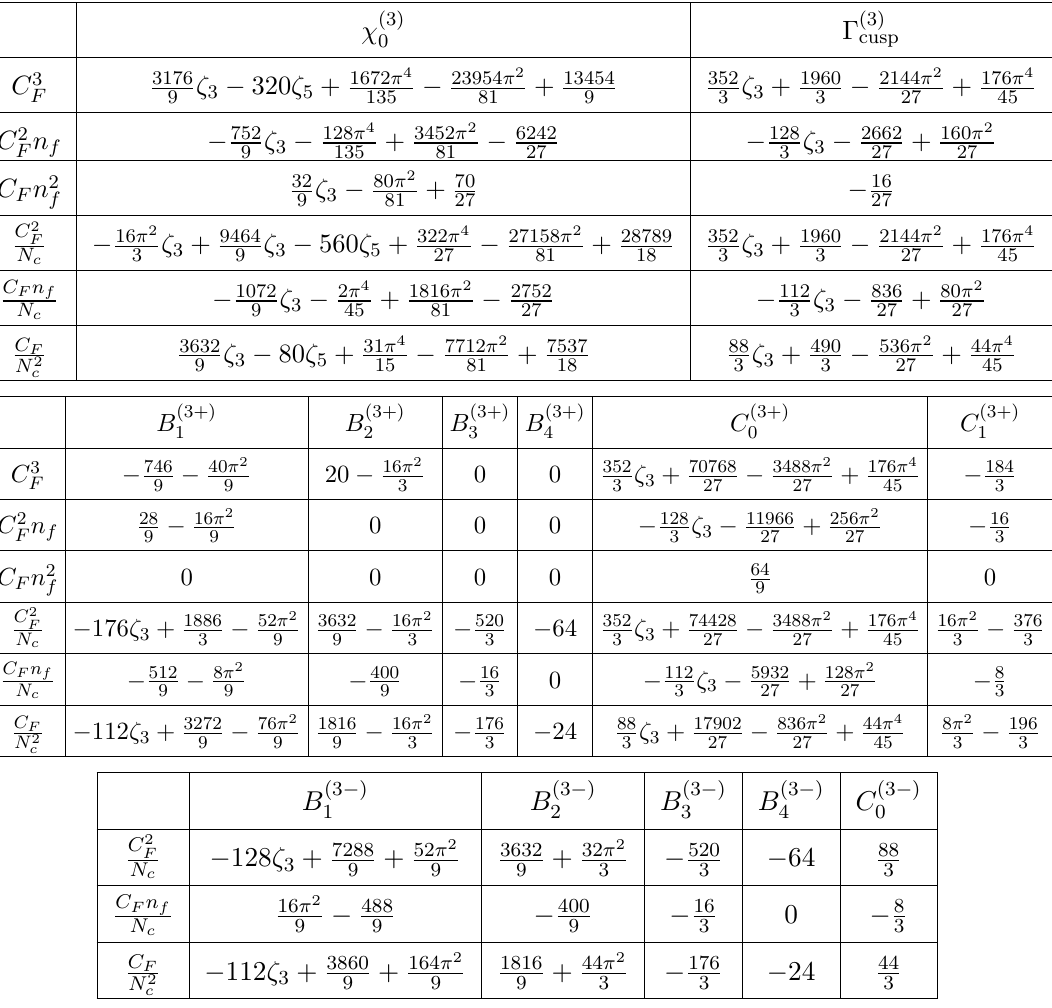
Table 1 . Cusp anomalous dimension (cid:0) (3) cusp (3.14) , constant term (cid:31) (3)